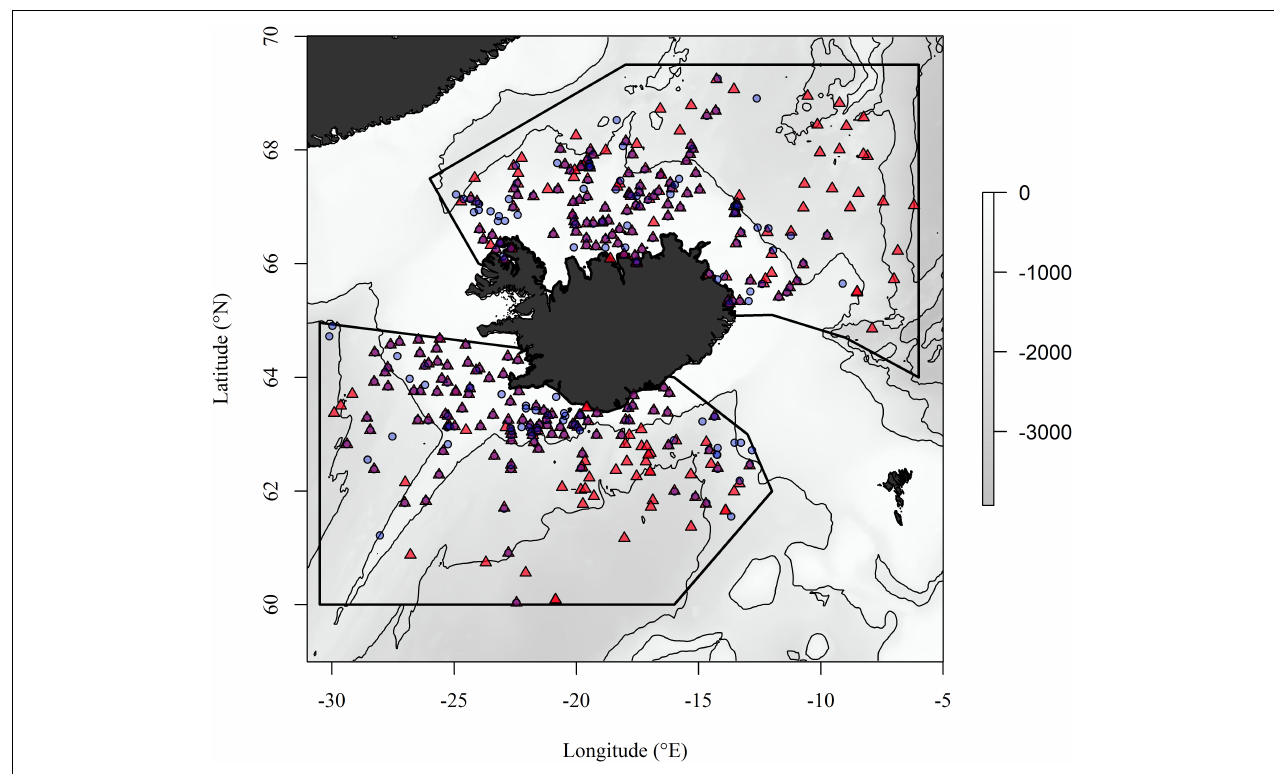
FIGURE 1 | The study regions north and south of the Greenland-Iceland-Faroe ridge and geographic location of BIOICE samples included in the study. Red triangles and blue circles are localities of benthic samples collected through towing a modified RP sled and Sneli sled, respectively. Contour lines are placed at 1000 m depth